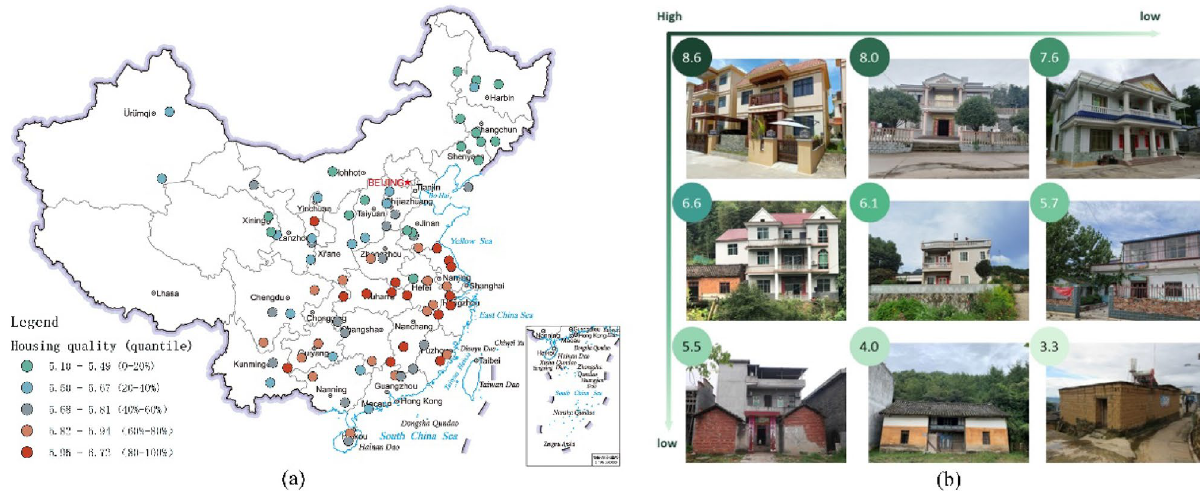
Figure 7. User’s assessment for crowd-scouring rural house images. ( a ) Presents the average housing quality of 83 counties across China with a warmer dot meaning higher quality, and ( b ) displays nine different levels of housing quality from high to low. The map is created by Arcgis 10.0, and the base map is provided by Standard Map Service System (http:// bzdt. ch. mnr. gov. cn). The photographs are provided by Guangzhou Guangzhou Urban Rural Habitat Planning and Design